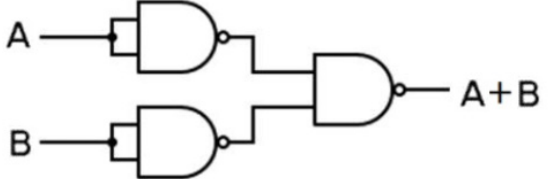
Figure 9. Classical OR gate.